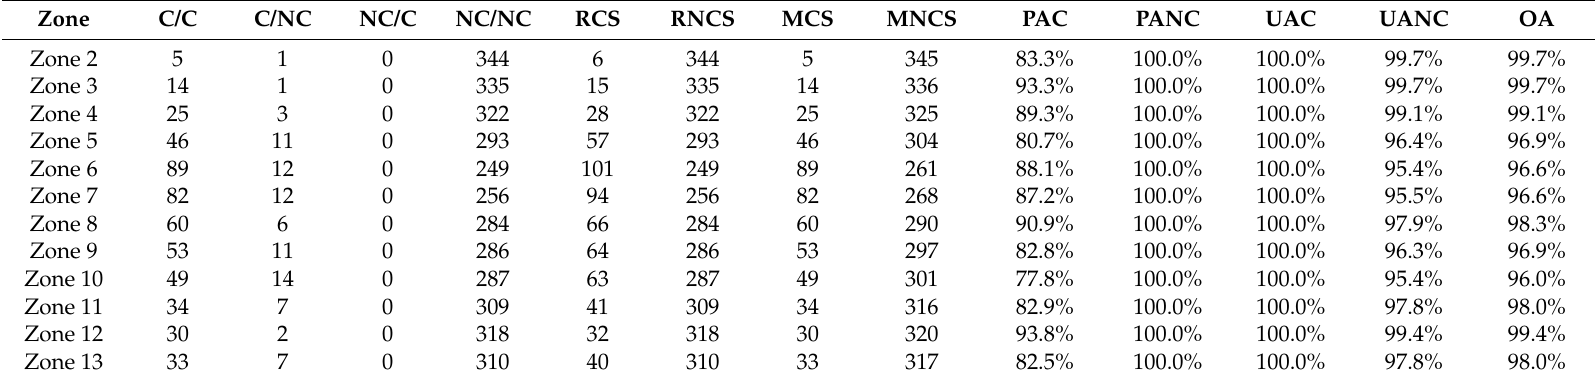
Table 1. Zone-wise accuracy estimates listed for all the AEZ’s of the United States.